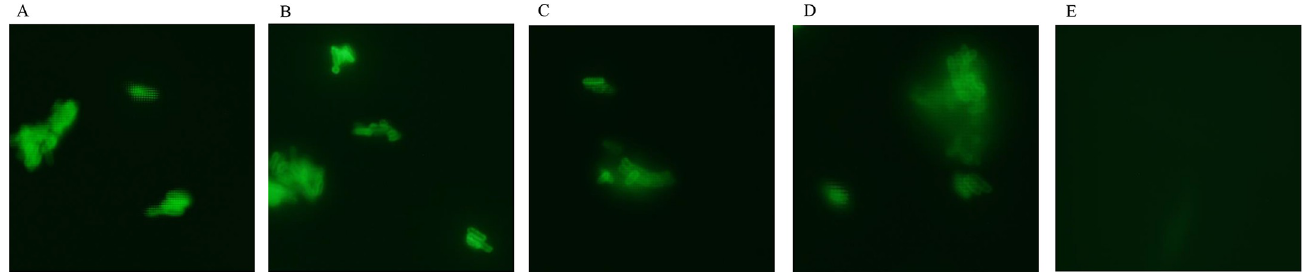
Fig 6. Indirect immunofluorescence staining of InvX expressing E . coli by Abs corresponding to each region of InvX. Visualization of the bacilli reveals bacterial surface binding of the fluorescent goat anti-rabbit IgG to rabbit anti InvX present of the cell surface. (A) InvXa, (B) InvXb, (C) InvXc, (D) InvXd and (E) normal rabbit